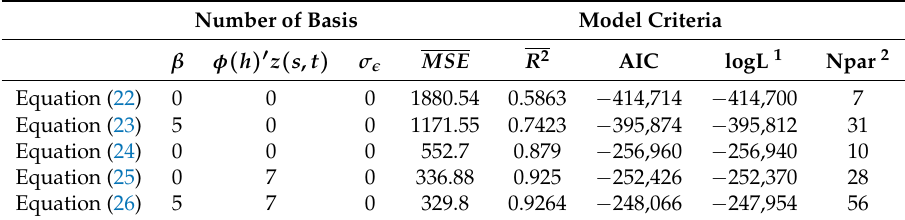
Table 3. MSE , R 2 , and AIC for the five